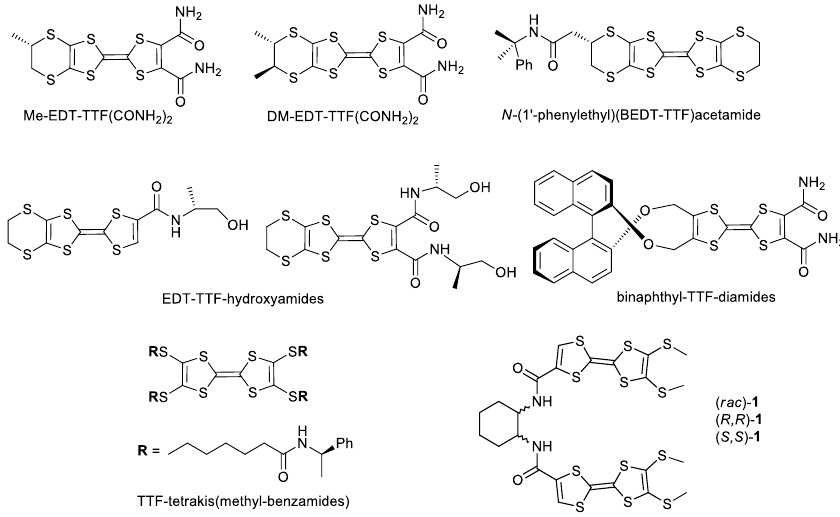
Figure 1. Examples of chiral TTF-amides; 1 is described in the present work.